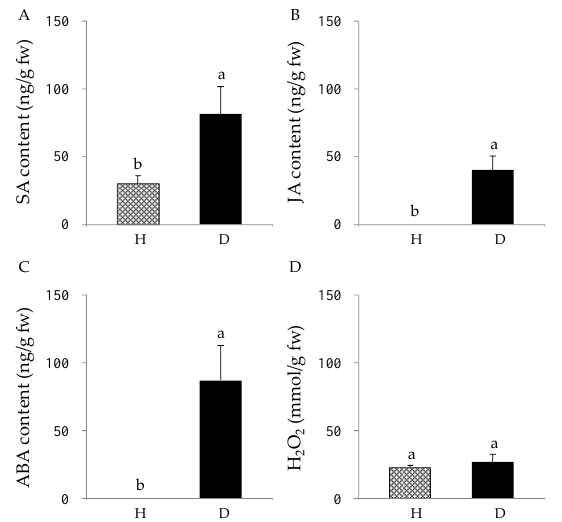
Figure 6. Accumulation of signal molecules in response to pruning. The amounts of SA ( A ), JA ( B ), ABA ( C ), and H 2 O 2 ( D ) in the D and H zones were compared.